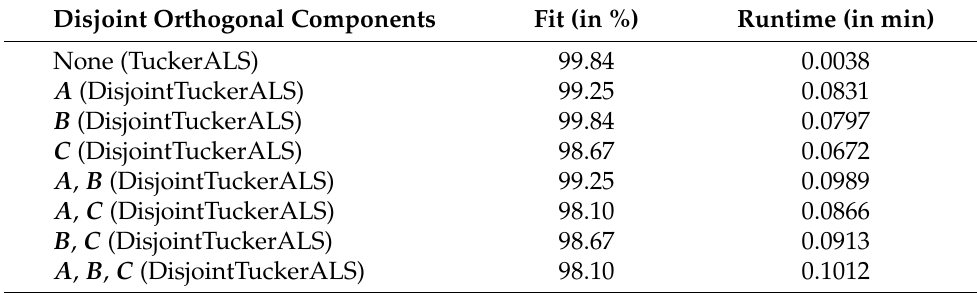
Table 13. Comparison of fit and runtime for behavioral level